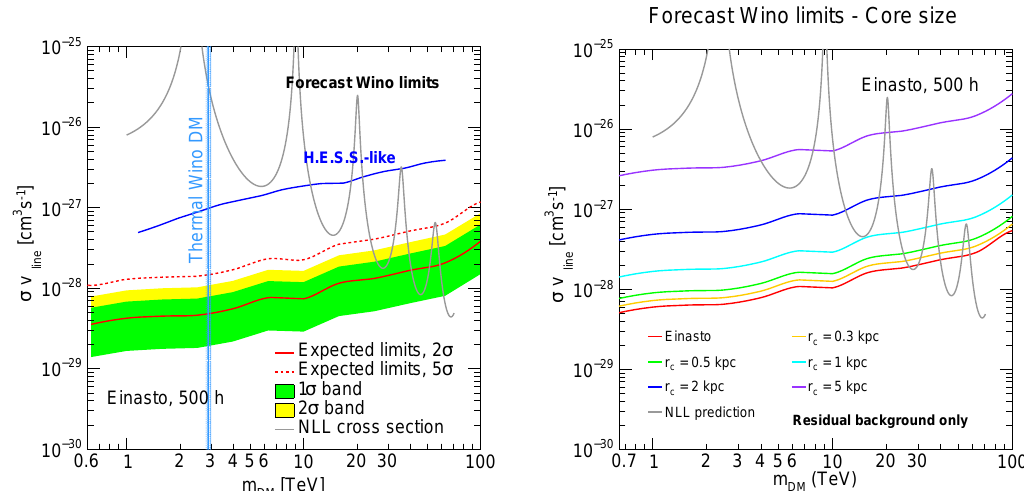
Figure 8: Left panel: The cross section for wino annihilation to produce a photon line, including the Sommerfeld enhancement and resummed logarithmic corrections (gray line), compared to the current sensitivity of H.E.S.S. (blue line) and the pro- jected sensitivity of a 500h observation with CTA (red line), assuming an Einasto profile for the DM density. Green and yellow bands indicate the 1 and 2 σ uncer- tainties on the expected 2 σ bound from CTA. The vertical blue band indicates the DM mass range yielding the correct relic abundance. Right panel: the variation of the expected constraint from CTA if the DM density profile has a flat-density core at small Galactocentric radii. Reproduced from Ref. [ 106 ] ; see that work for details.